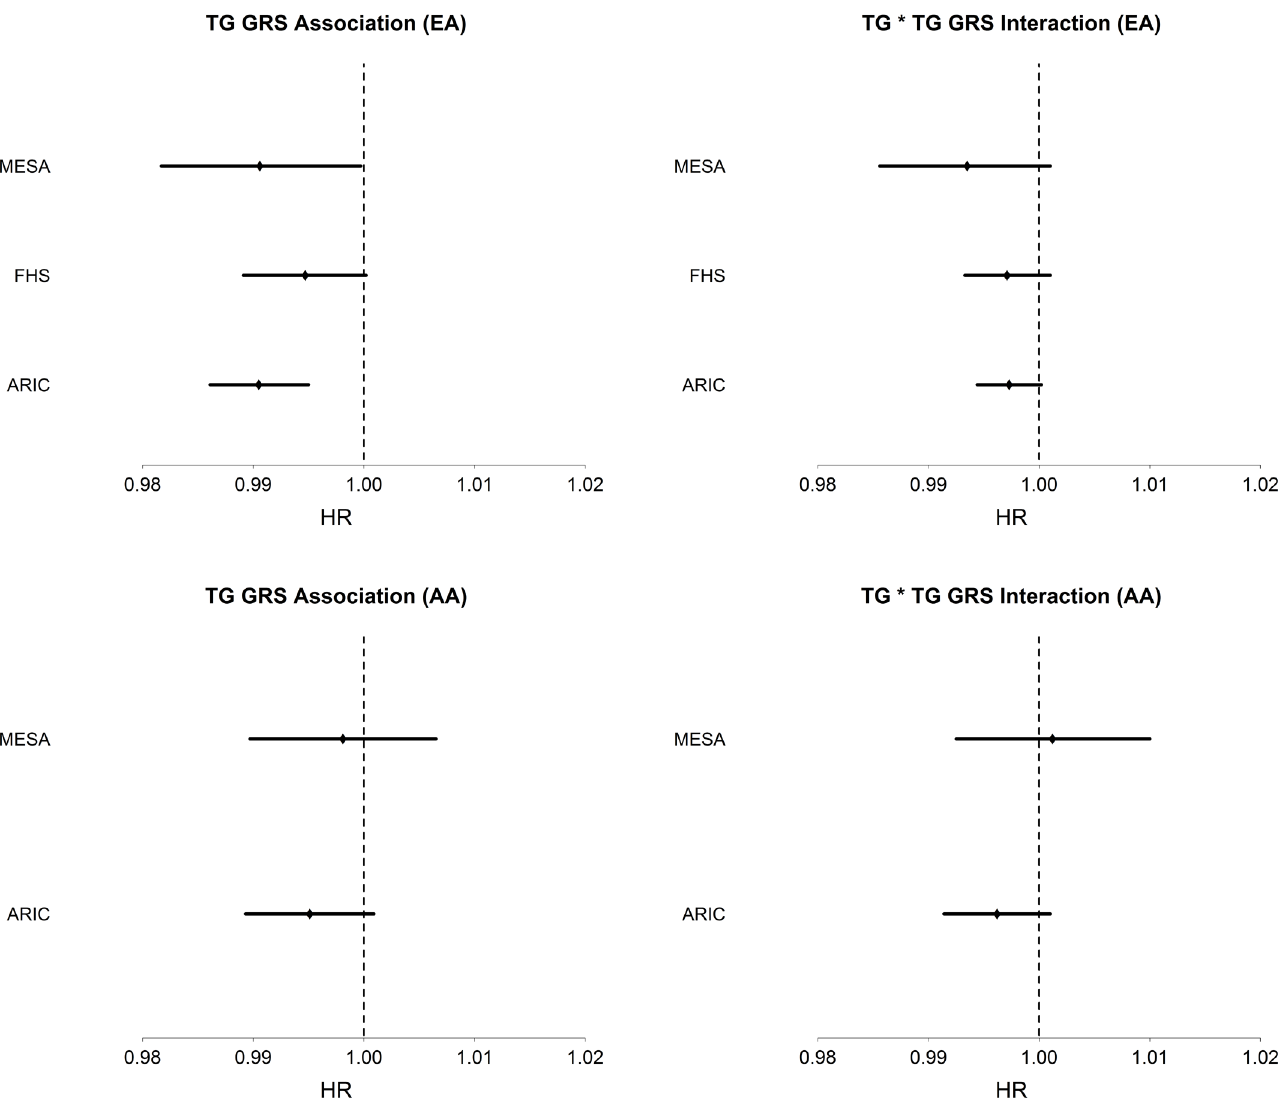
Fig 1. Association of TG GRS with incident T2D and interaction of TG with TG GRS on incident T2D in each dataset and in EA (top; n = 13,247) and AA (bottom; n = 3,238). Hazard ratios and 95% CI are shown. Covariates include age, sex, BMI, TG, and